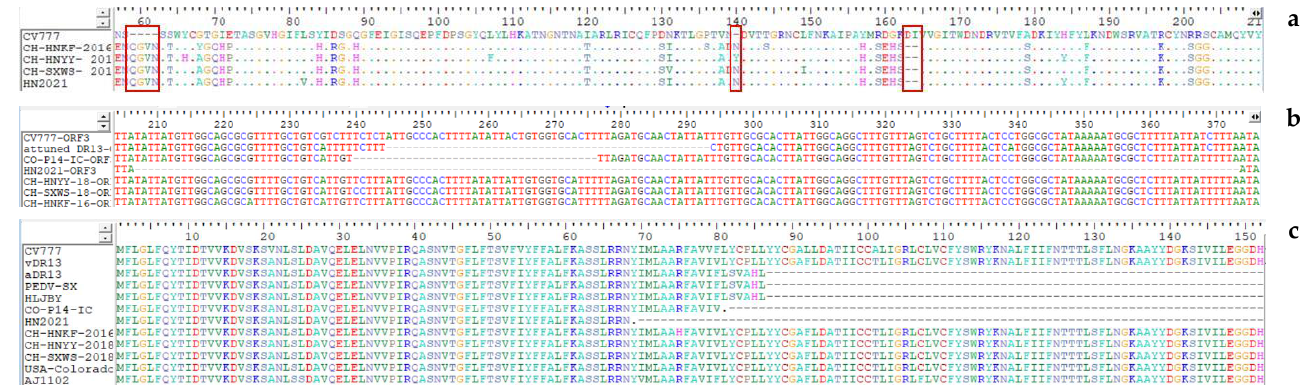
Figure 1. Partial genome comparison between the 4 PEDV strains in this study and the reference strains. ( a ) Compared with CV777 strain, the 4 strains displayed common 3 aa deletions or 5 aa insertions occurring in the N-terminal domain of the S protein, of which a distinct change (N140Y) in the insertion site was observed in CH-HNYY-2018. ( b ) The ORF3 gene of classic virulent strain CV777 was complete, and the attenuated DR13 strain had 49 nucleotide deletions at 245–293 nt, CO/P14/IC possessed 37 nucleotide deletions at 240–276 nt, the naturally truncated strain HN2021 exhibited 167 continuous nucleotide deletions at 207–373 nt. ( c ) Attenuated-DR13, HLJBY and PEDV-SX ORF3 proteins were 91 aa, which had 133 aa deletions at C’. CO/P14/IC ORF3 protein was 80 aa, with 144 aa deletions at C’ end, and the HN2021 owned the shortest ORF3 protein of all strains in this study, which was 68 aa, with 156 aa deletions at C’ end. Table 2. Amino acid mutations in neutralizing epitopes of the putative S protein of 4 PEDV strains from this study compared with